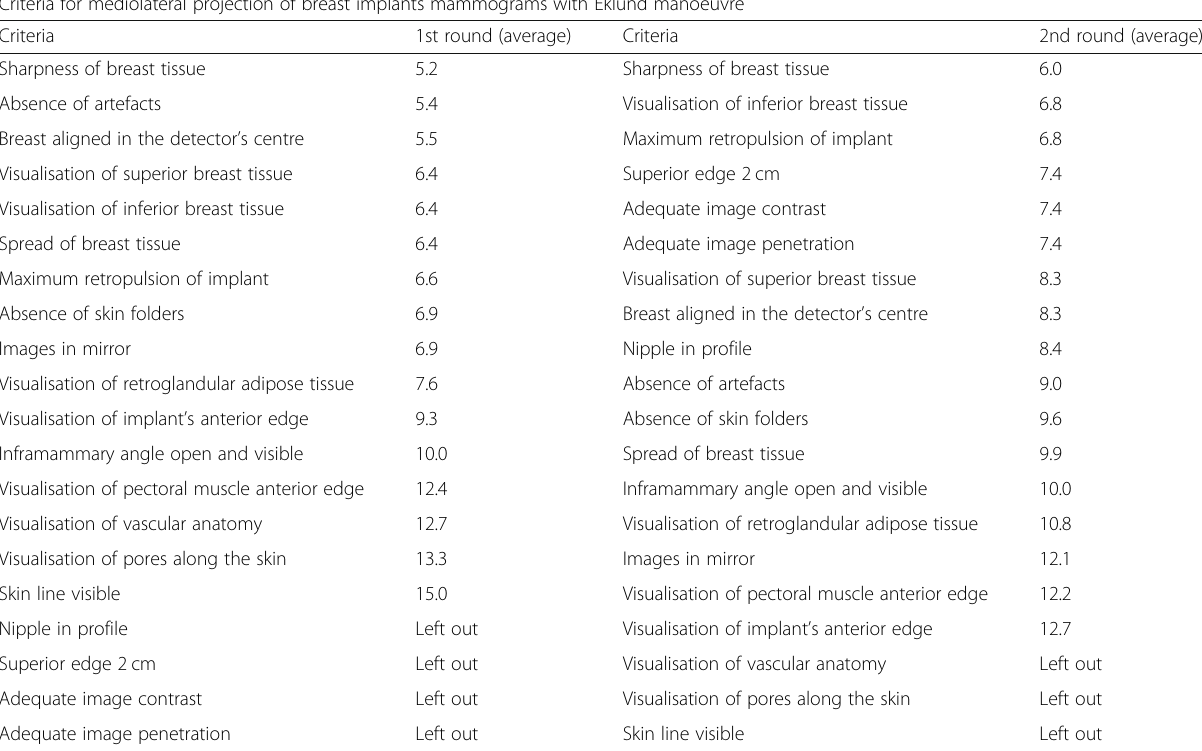
Table 7 Criteria rakings (mean values based on Kendall ’ s W ) comparison between first and second Delphi rounds regarding mediolateral image manoeuvre combining the opinions of both groups (radiologists and radiographers) Criteria for mediolateral projection of breast implants mammograms with Eklund manoeuvre Criteria